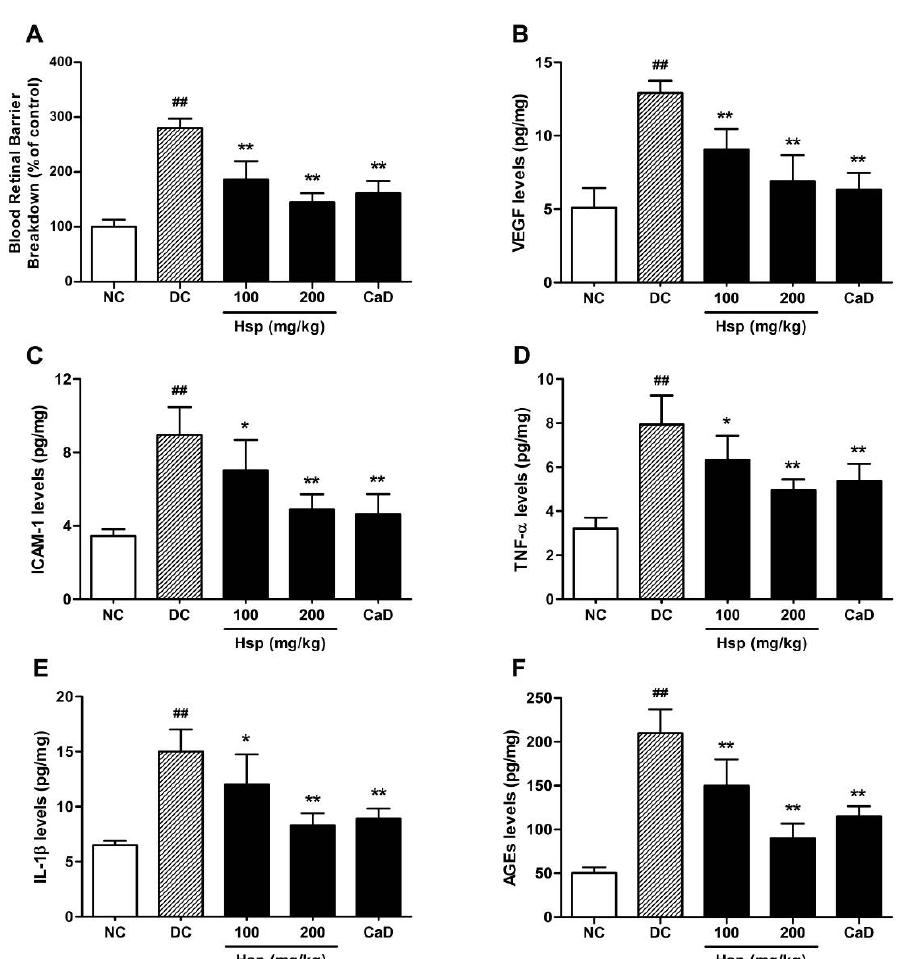
Figure 3. Effects of Hsp and CaD on ( A ) BRB breakdown; retinal levels of ( B ) VEGF; ( C ) ICAM-1; ( D ) TNF- α ; ( E ) IL-1 β ; and ( F ) AGEs in rats. ## p < 0.05 as compared with the NC group; * p < 0.05, ** p < 0.01 as compared with the DC group; NC, Normal Control; DC, Diabetic Control. The data represent means ±